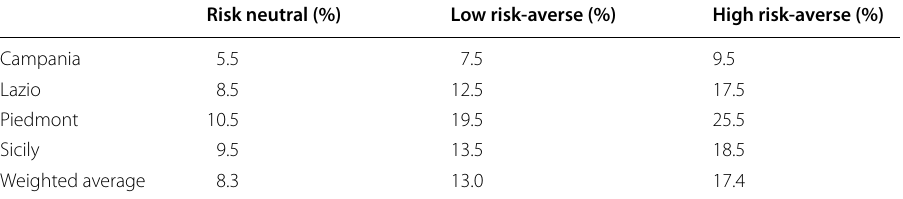
Table 4 Maximum contribution rate making farmers indifferent to participate in the IST—three risk aversion’